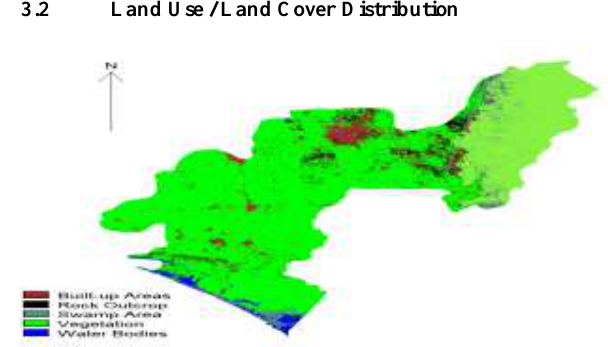
Figure 4. Land Use / Land Cover Map of Ondo State in 2013.